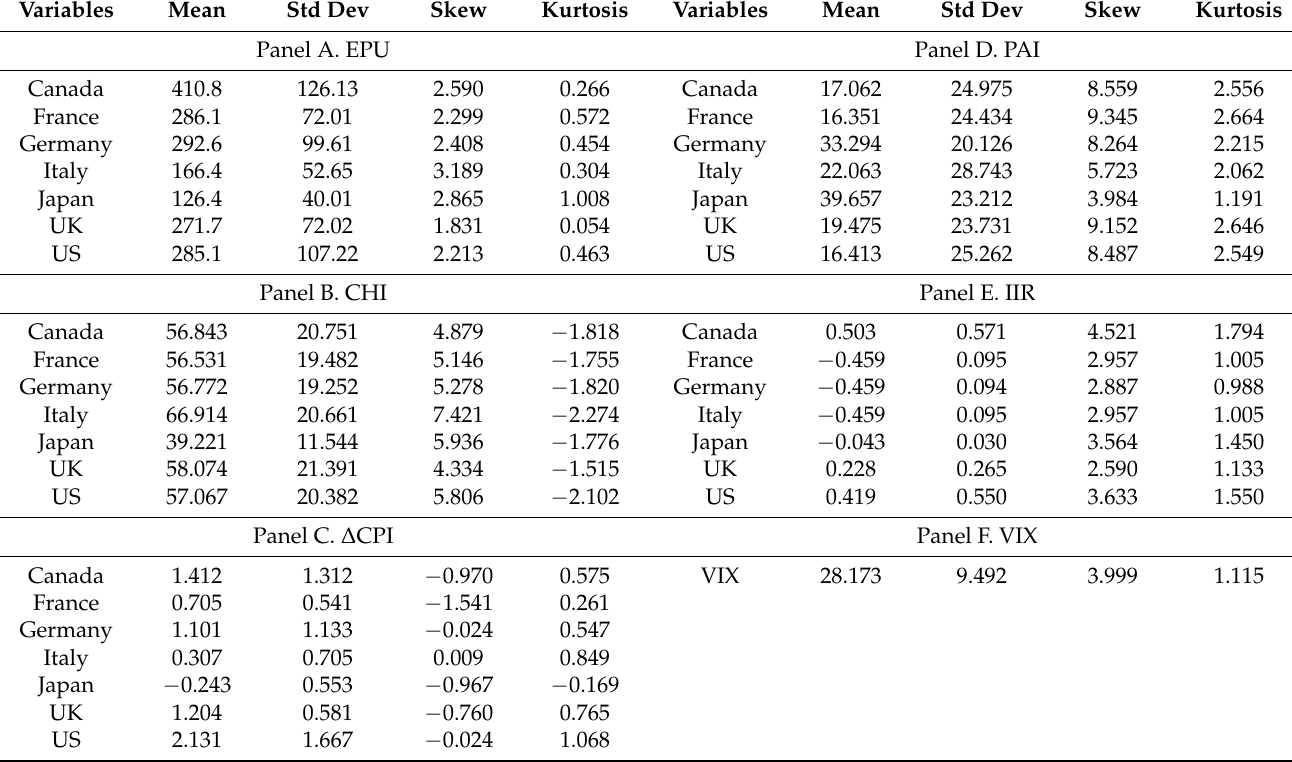
Table 2. Summary Statistics of Market Uncertainties and Macroeconomic